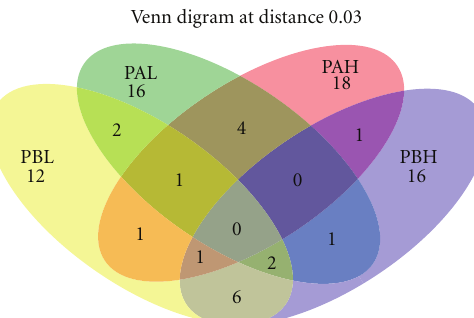
Figure 4: Venn diagram of bacterial OTUs clustered with a 3% distance threshold, showing the number of OTUs shared by the four crude oil samples. PAL—crude oil from Platform A with low-water content (5%); PAH—crude oil from Platform A with high-water content (60%); PBL—crude oil from Platform B with low-water content (1%); PBH—crude oil from Platform B with high-water content